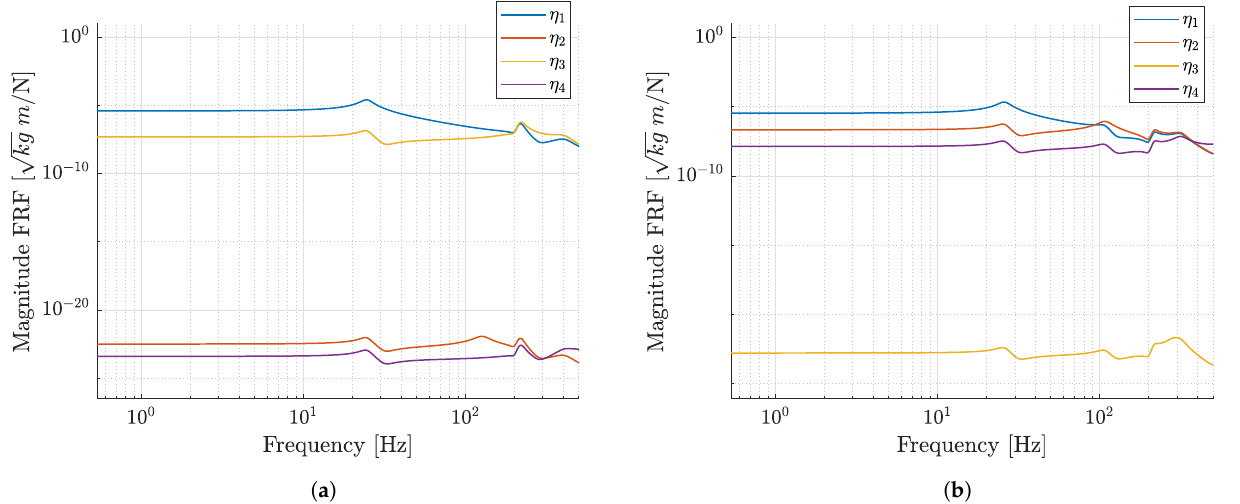
Figure 18. FRFs of the modal coordinate η r . ( a ) Cutting head in the front-center (FC) position ( x b = L /2). ( b ) Cutting head in the center-center (CC) position ( x b = L